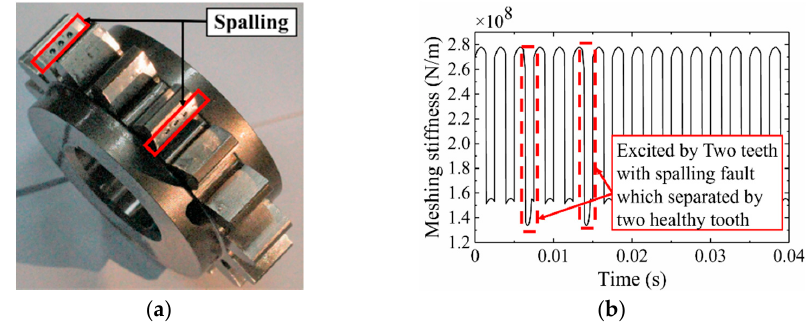
Figure 14. Status of tooth surface and mesh stiffness curves (two teeth with spalling fault, which are separated by two healthy teeth): ( a ) status of tooth surface and ( b ) mesh stiffness curves.